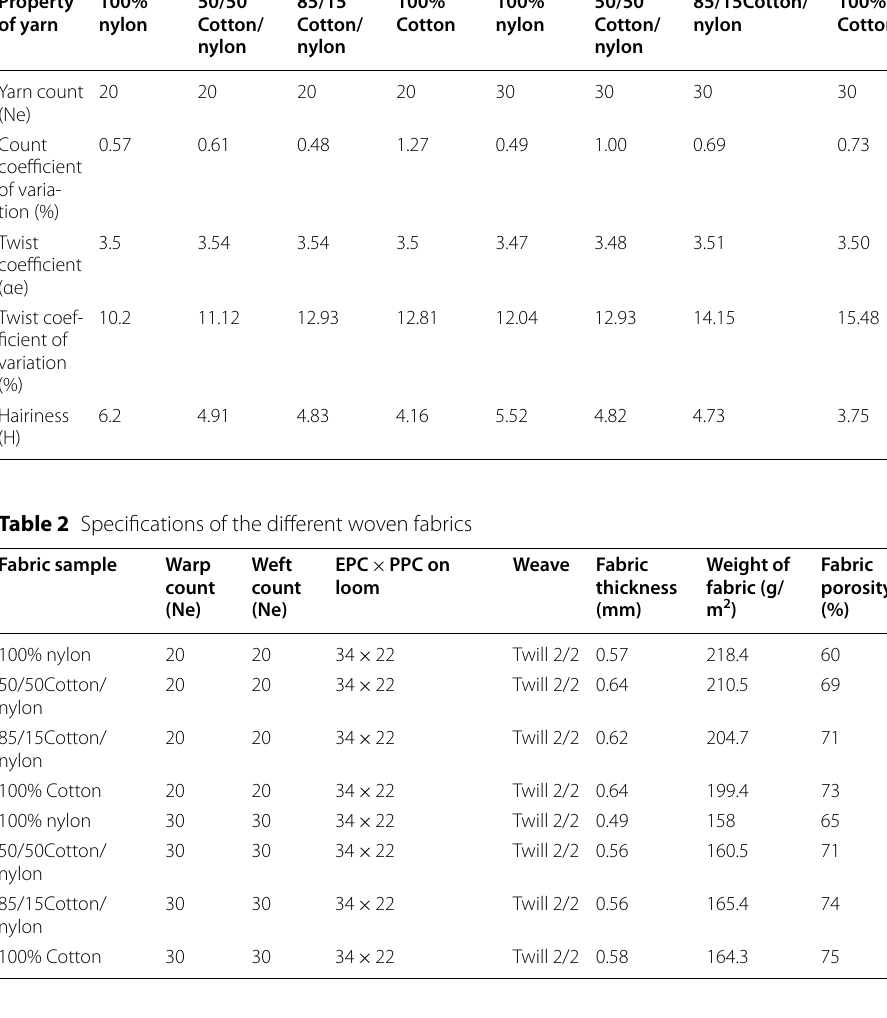
Table 1 Yarn specifications Property of yarn